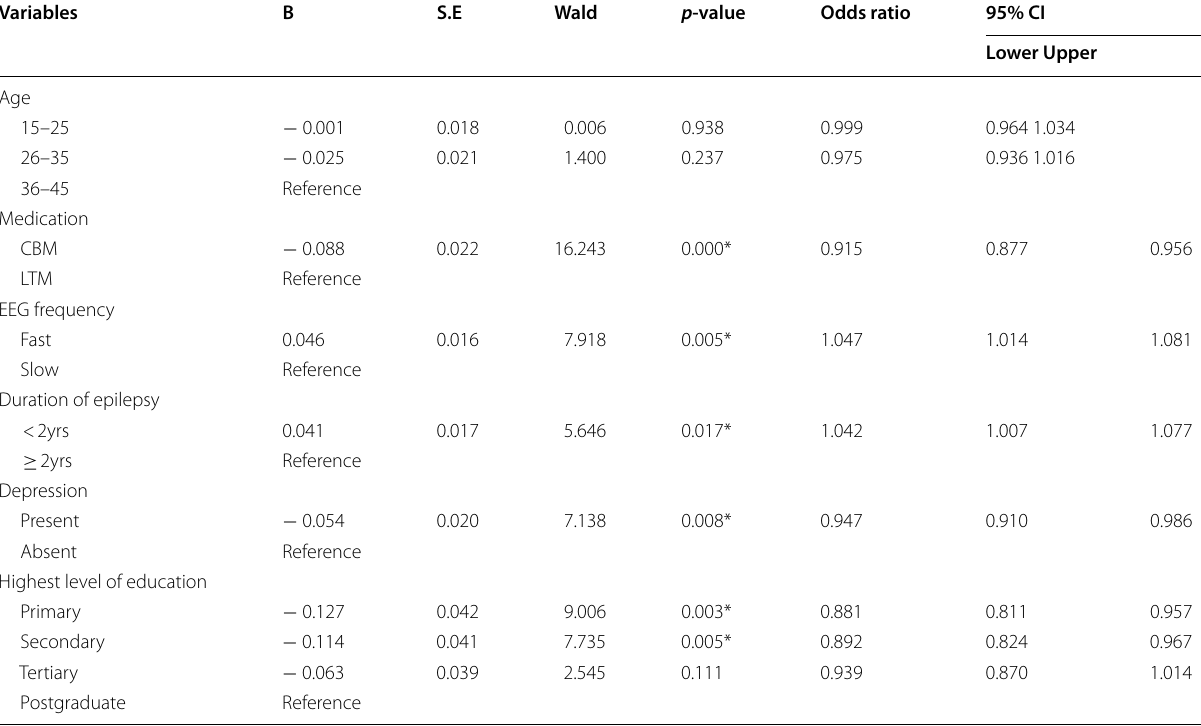
Table 5 Showing logistic analysis of the correlates of QOLIE‑TS